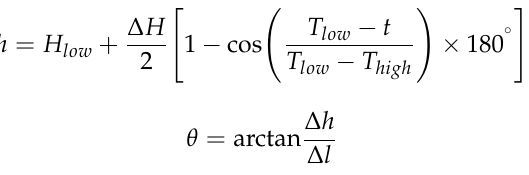
Figure 4. Tidal correction schematic diagram using instantaneous water edges. Table 1. Tidal information calculated by the remote sensing images at the scene center time.